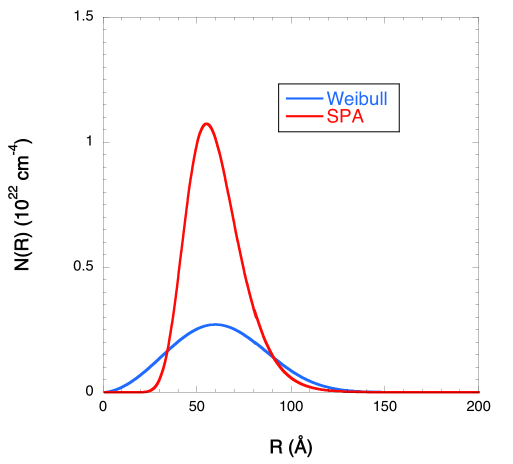
Figure 10. Ludox silica particles HS30 with a 0.3% volume fraction: the Weibull SDF (blue line) obtained with the fitting procedure, with corrections for the wavelength spread ( ∆ λ / λ = 18%) and for the multiple scattering, and the lognormal SDF (red line) calculated with the